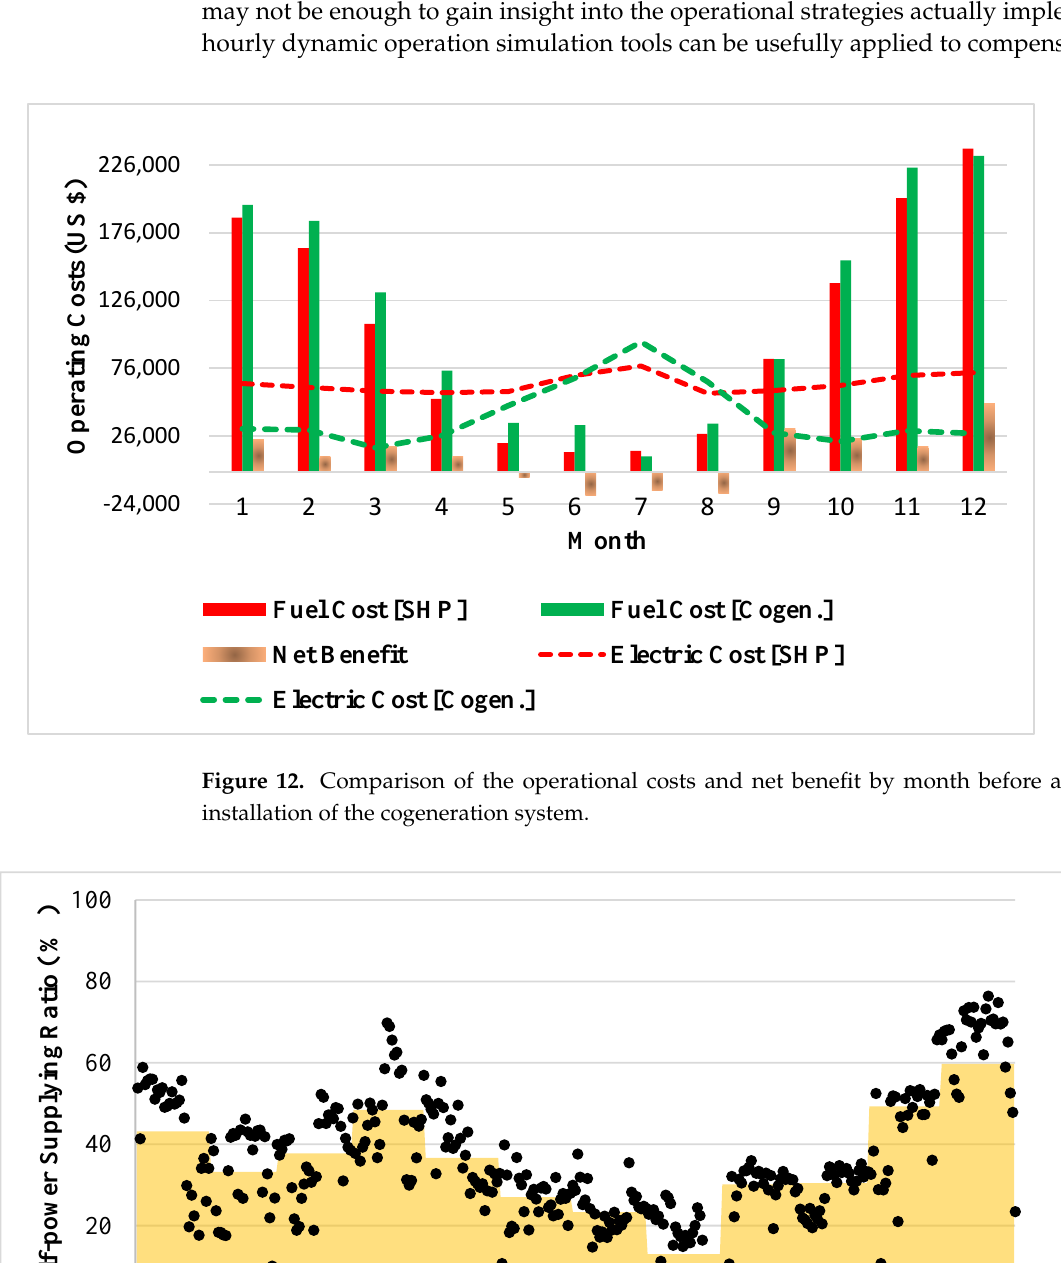
Table 5. System and operating conditions for the scenarios. Type of Operation Identification Device Capacity [kWh]